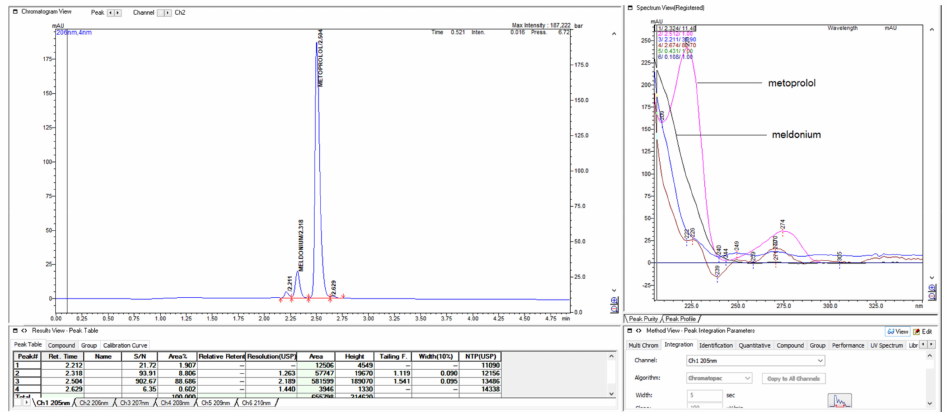
Figure 43. Chromatograms, obtained by usage mobile phase composed of 70% ACN and 30% 0.07% v / v TFA, with exceptionally short run times lasting less than 3 min, with perfect shaped all peaks, but with no impressible resolution between them. UV spectrum extracted peaks on the